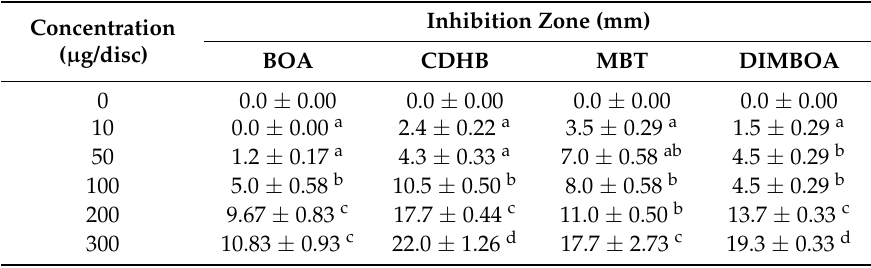
Table 1. Disk diffusion susceptibility testing results for DIMBOA and its